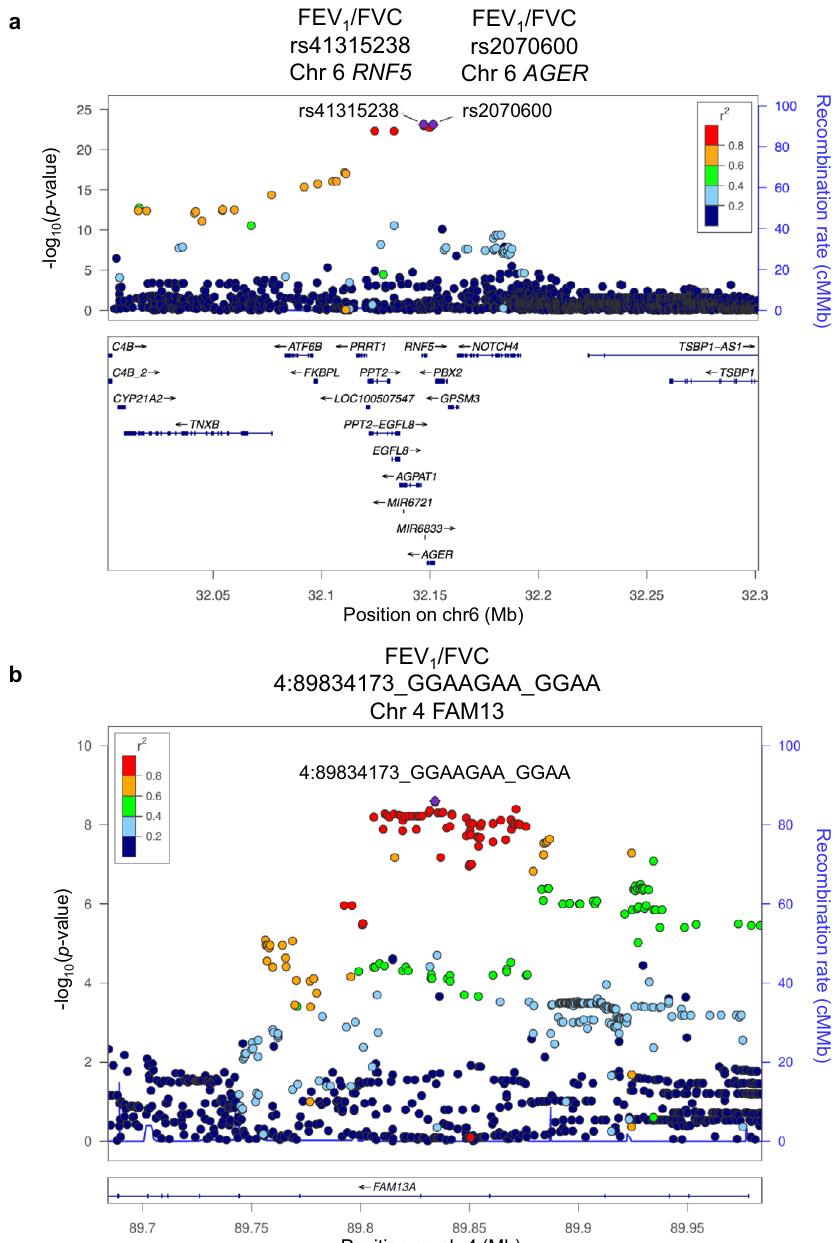
Fig. 3 Regional association plots of the loci associated with FEV 1 /FVC at both Discovery and Validation Stages. a , b Statistical signi fi cance of each genetic variant on the − log10 scale as a function of chromosome position (hg19) at the Discovery Stage alone. The sentinel variant at each locus is shown in purple. The correlations ( r 2 ) of each of the surrounding variants to the sentinel variant are shown in the indicated colours. In Fig. 4a, the correlations to rs2070600 are shown. The locus shown in Fig. 4a is a tier 1 locus that showed an association with FEV 1 /FVC with P < 5 × 10 − 8 both at the Discovery Stage and Validation Stage. The locus in Fig. 4b is tier 2 locus that showed an association with FEV 1 /FVC with P < 5 × 10 − 8 at the Discovery Stage and P < 5 × 10 − 5 at the Validation Stage with consistent directions of effect. FEV 1 forced expiratory volume in one second, FVC forced vital